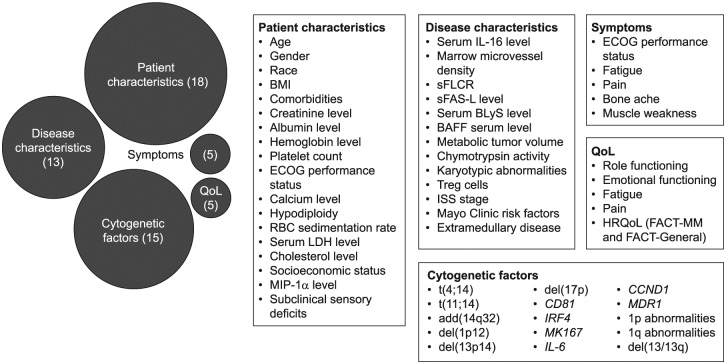
Variables in each category that have a significant relationship with
another attribute.BAFF, B-cell activating factor; BLyS, B-lymphocyte stimulator; BMI, body
mass index; CCND1, gene encoding cyclin D1;
CD81, gene encoding cluster of differentiation 81;
ECOG, Eastern Cooperative Oncology Group; ESR, erythrocyte sedimentation
rate; FACT-MM, Functional Assessment of Cancer Therapy–Multiple Myeloma;
HRQoL, health-related quality of life; IL, interleukin;
IRF4, gene encoding interferon regulatory factor 4;
ISS, International Staging System; LDH, lactate dehydrogenase;
MDR1, multidrug resistance gene 1; MIP-1α,
macrophage inflammatory protein 1α; MKI67, gene
encoding marker of proliferation Ki-67; MM, multiple myeloma; QoL,
quality of life; RBC, red blood cell; sFAS-L, soluble Fas ligand; sFLCR,
serum free light-chain ratio.Numbers in brackets are the number of attributes in each group. In total,
56 MM attributes were identified as significant, that is, those that
have a significant relationship with another attribute; these were
grouped into five categories: disease characteristics,44–54
cytogenetic factors,55–59 patient
characteristics,45–48,51,53,55,60–81 QoL,69,75,82,83
and symptoms.46,69,71,82–87